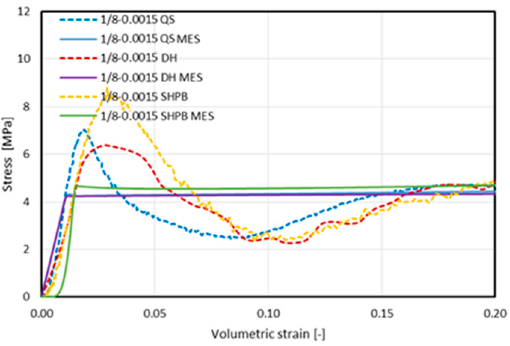
Figure 17. Summary of stress–volumetric strain characteristics obtained using the FEM–homogeneous model (FEM) and experimentally (exp) [21] at a quasi-static load (QS) strain rate of 8.3 × 10 − 2 1/s, at a dynamic load (DH) strain rate of 3.8 × 10 2 1/s), and using a Split Hopkinson Pressure Bar (SHPB) at a strain rate of 3.3 × 10 3 1/s of the sample 1/8-5052-0.0015 for a strain limited to <0;0.2> scope.